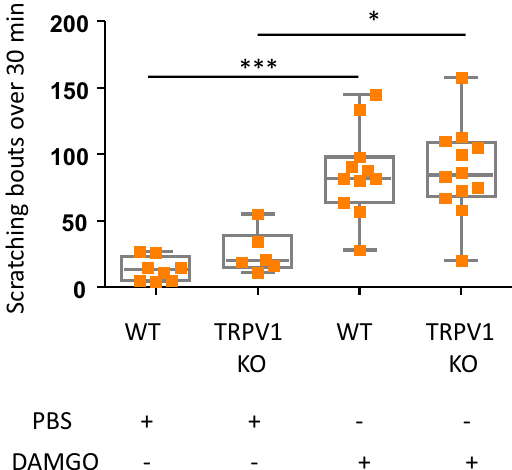
Figure 4. DAMGO induces itch in TRPV1 deficient mice. Scratching bouts evoked by intradermal injections of either PBS or DAMGO (200 µ M) in WT (PBS; n = 8, DAMGO; n = 11) and TRPV1 deficient mice (PBS; n = 6, DAMGO; n = 12). Results are represented as Whisker-dot plot (Min-Mean-Max) and each symbol represents an individual mouse. Statistical analysis were performed using Kruskall-Wallis followed by post-hoc Dunn’s test ( *** p < 0.001 WT + DAMGO versus WT + PBS and * p < 0.05 TRPV1 KO + PBS versus TRPV1 KO +